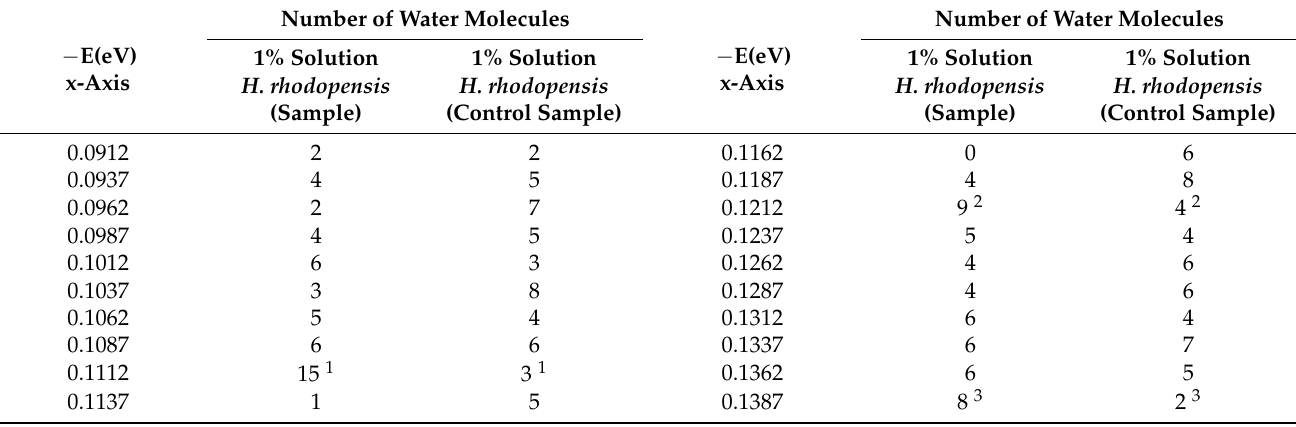
Table 1. Distribution of the number of water (H 2 O) molecules in a 1% solution of Haberlea rhodopensis Friv. blossom extract in EVOdrop-filtered tap water saturated with Hydrogen (H 2 ) and in the control sample of tap water from Sofia, Bulgaria according to the energy of hydrogen bonds.